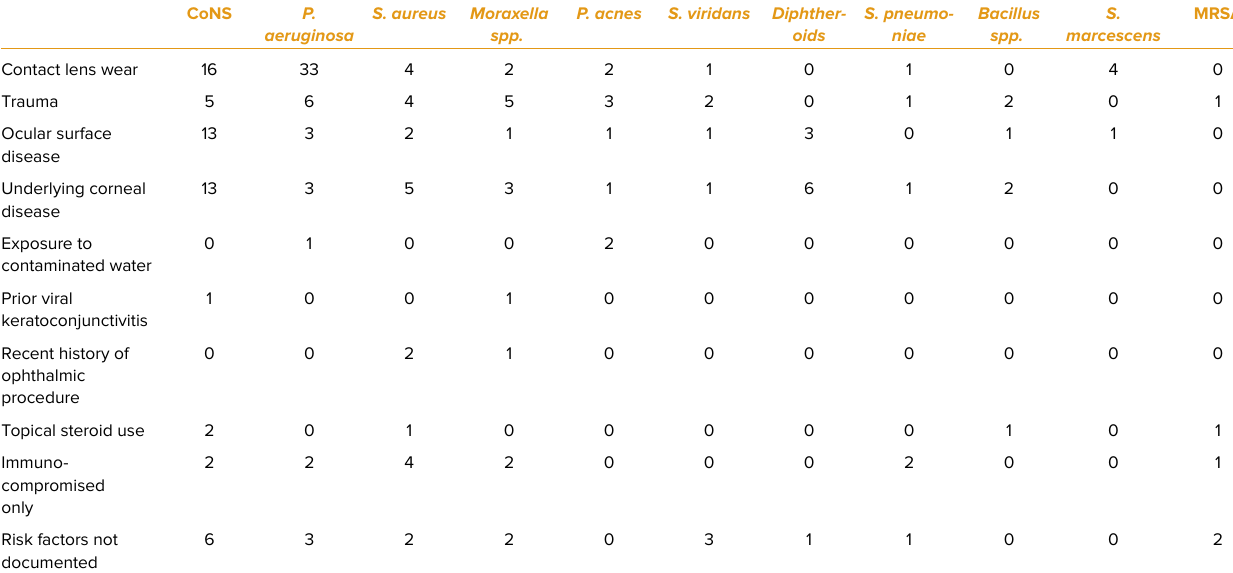
Table 3. Predisposing factors identified in patients with corneal ulcer caused by the most prevalent bacterial